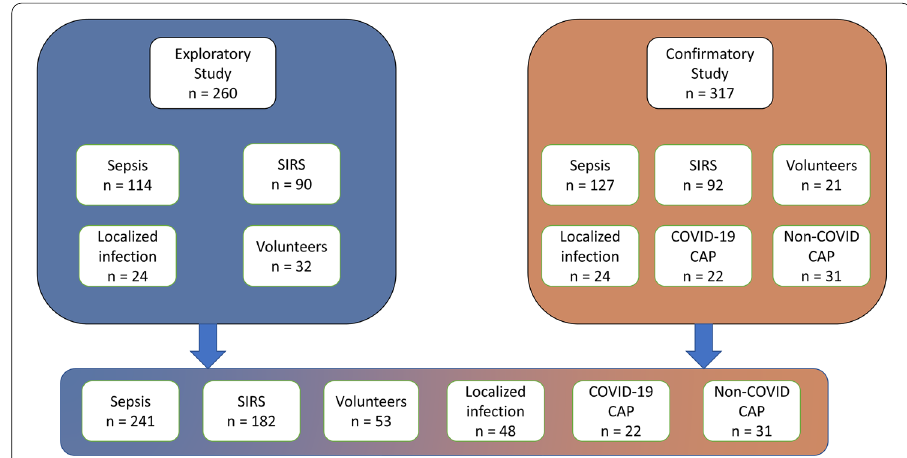
Fig. 1 Flowchart describing the origin of the study population, divided by exploratory and confirmatory study. Overall, the exploratory study population consists of 260 individuals (including 114 patients with sepsis, 90 patients with SIRS, 24 patients with localized infection and 32 volunteers) and the confirmatory sample consists of 317 individuals (including 127 patients with sepsis, 92 patients with SIRS, 24 patients with localized infection, 22 patients with a COVID‑19 CAP, 31 patients with non‑COVID‑19 CAP as well as 21 volunteers). The community‑acquired pneumonia (COVID and non‑COVID) groups are only represented in the confirmatory